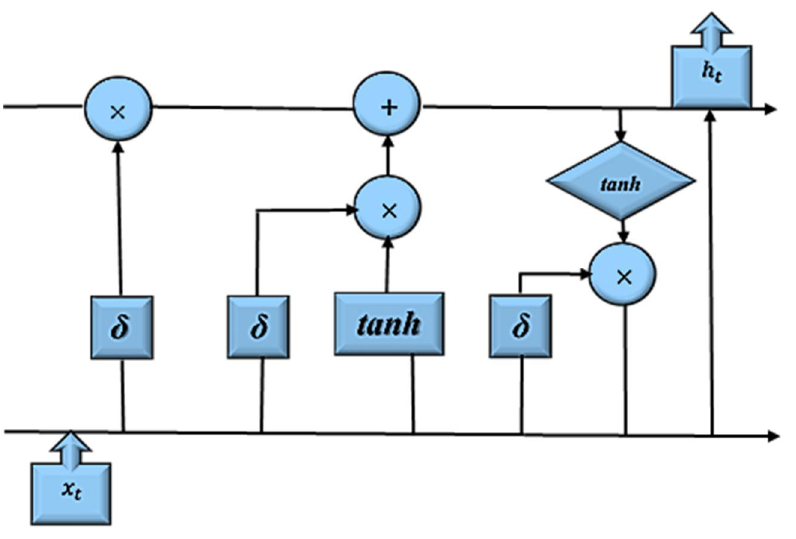
Figure 7. Figure shows the cell block representation on how the input is processed within the LSTM network.